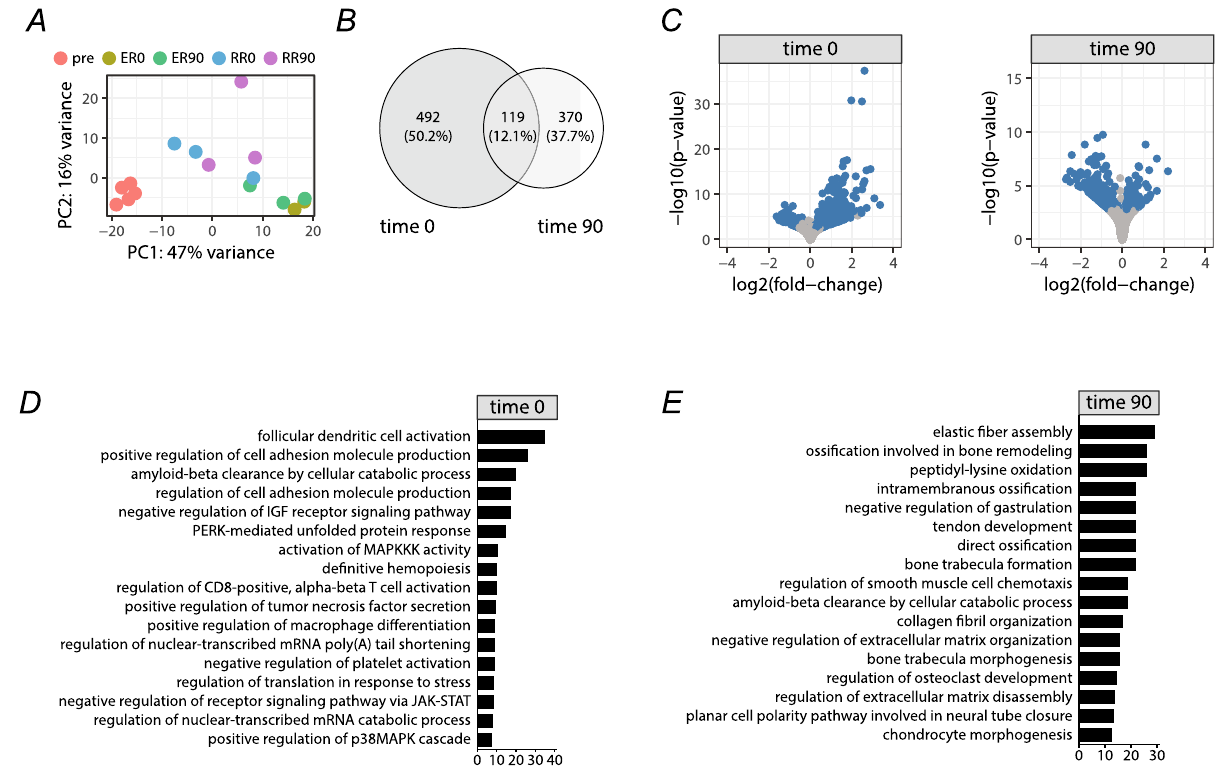
Figure 6. Initial analysis of ER-Arm: R-Arm RNASeq data. PCA plot of individual samples shows good clustering of pre-training samples and individual exercise protocols ( A ). Analysis of differentially expressed genes identified 611 genes expressed differentially at time 0 min (immediately after the exercise) and 489 genes expressed differentially 90 min after the exercise. Out of these, 119 were common ( B ). Volcano plots of expression fold changes with relation to p-values for individual analyzed time points. R-Arm protocol was chosen as a baseline ( C ). Top PantherDB-Gene Ontology pathways identified based on differential expression of genes between ER-Arm and R-Arm exercise protocols at two different time points (0 min, 90 min) ( D , E